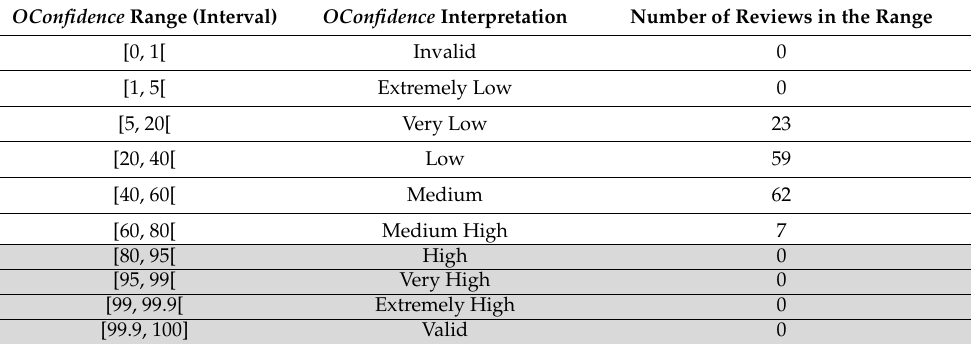
Table 3. Confidence of the Review